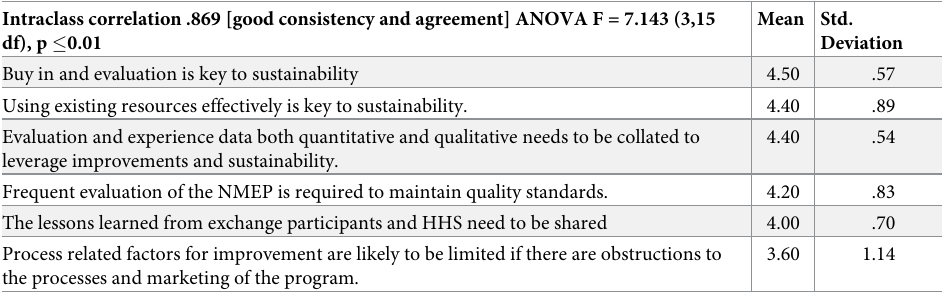
Mean Std. Deviation 4.40 .54 3.60